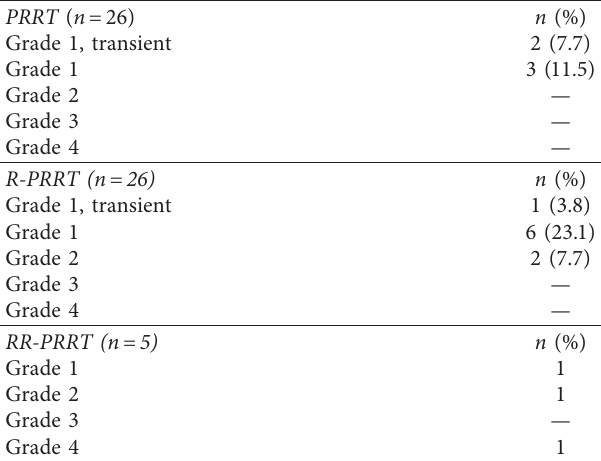
Table 3: Renal toxicity of [ 90 Y]Y/[ 177